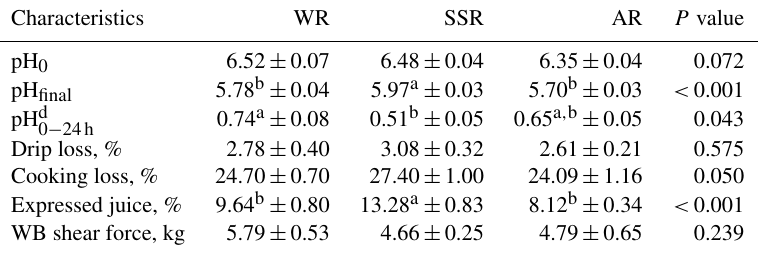
Table 4. Means ± SE for pH, drip loss, cooking loss, expressed juice and Warner–Bratzler (WB) shear force values of longissimus dorsi muscle of lambs reared in different seasons.